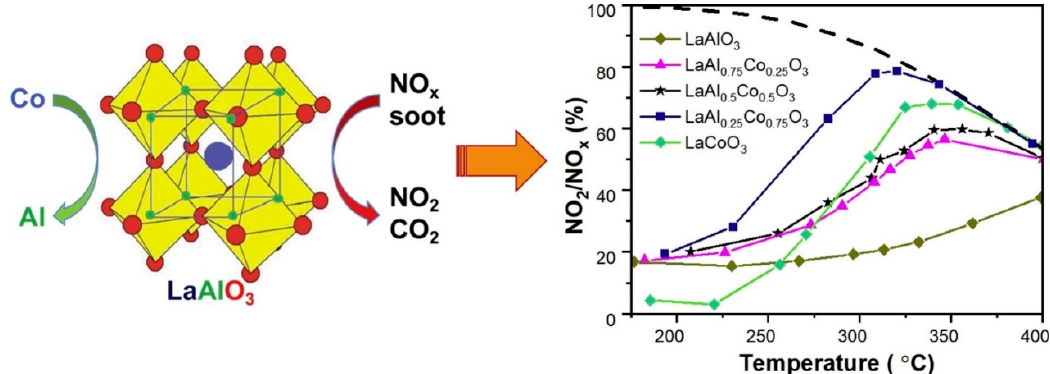
Figure 29. Structure of Co-doped LaAlO 3 perovskite and the NO 2 percentage for LaAl 1 − x Co x O 3 calcined at 700 °C (Reprinted with permission from [20]).